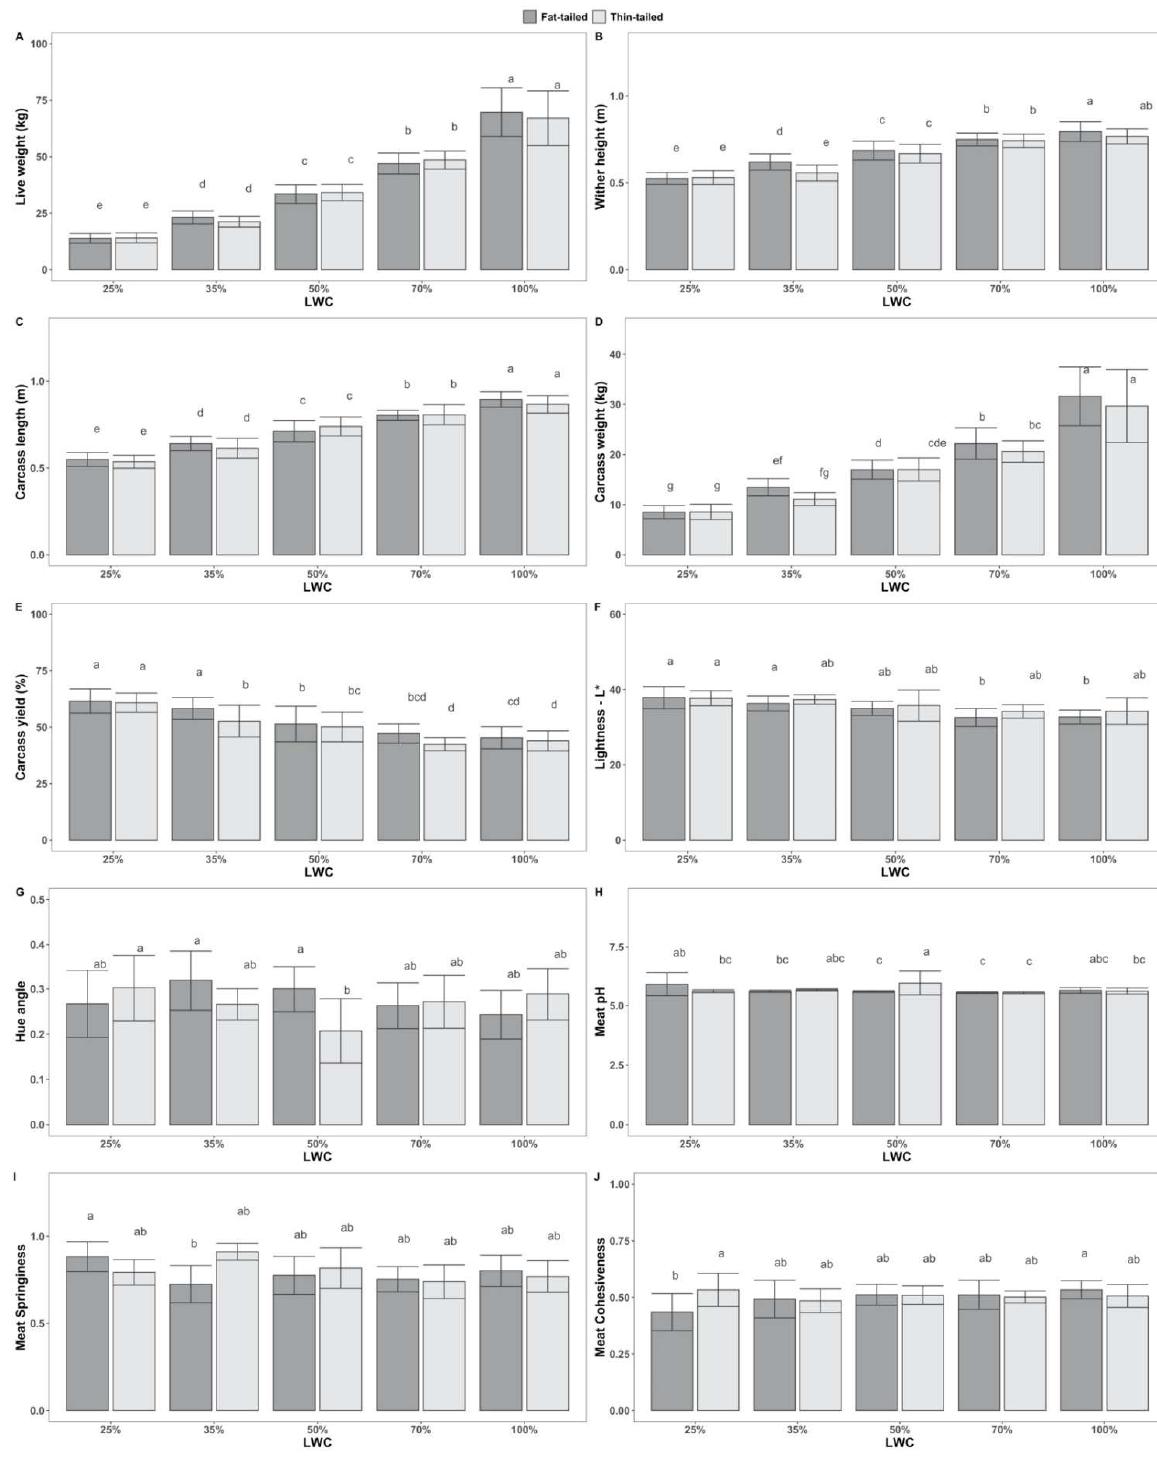
Figure 2. Tukey’s post hoc tests for pairwise comparisons between groups, following two-way ANOVA, accounting for the effect of the interaction between live-weight categories (LWC—25, 35, 50, 70 and 100% of mature live weight) and sheep populations (fat-tailed, thin-tailed) on the tested traits: ( A ) Live weight—in kg; ( B ) Wither height—in m; ( C ) Carcass length—in m; ( D ) Carcass weight—in kg; ( E ) Carcass yield—as %; ( F ) Lightness—L*; ( G ) Hue angle; ( H ) Meat pH; ( I ) Meat Springiness; ( J ) Meat Cohesiveness. Superscripts not sharing any common letter between groups indicate statistically significant differences ( p <